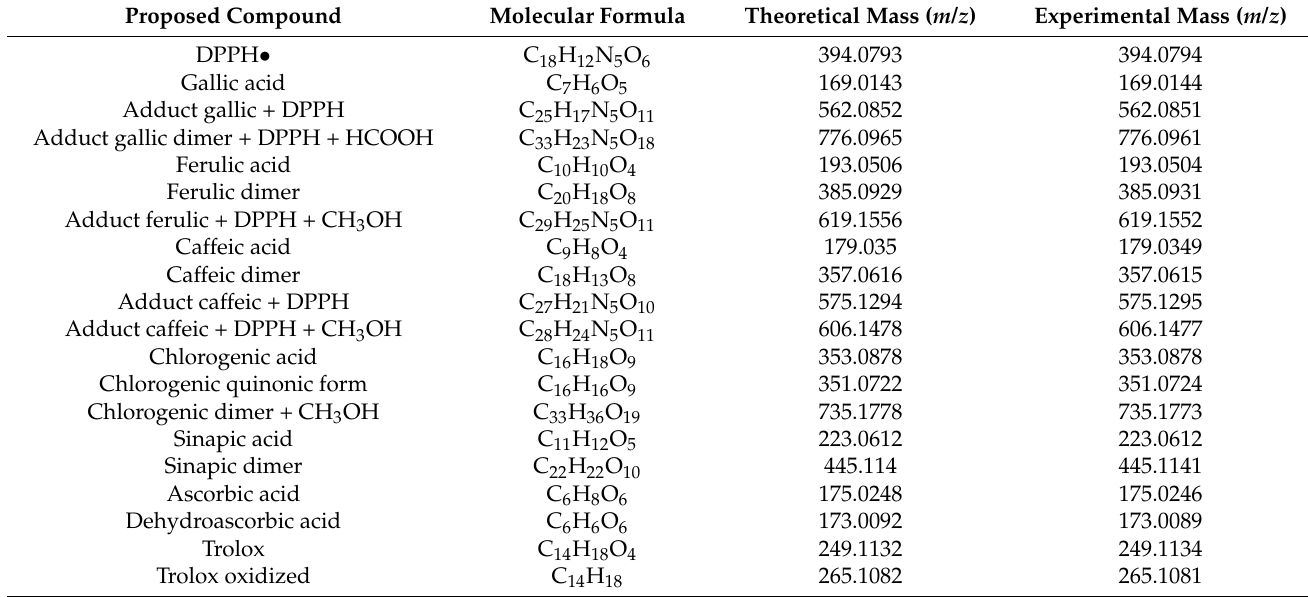
Table 3. Proposed compounds with corresponding molecular formula and theoretical and experimental mass. Proposed Compound Molecular Formula Theoretical Mass ( m / z ) Experimental Mass ( m / z